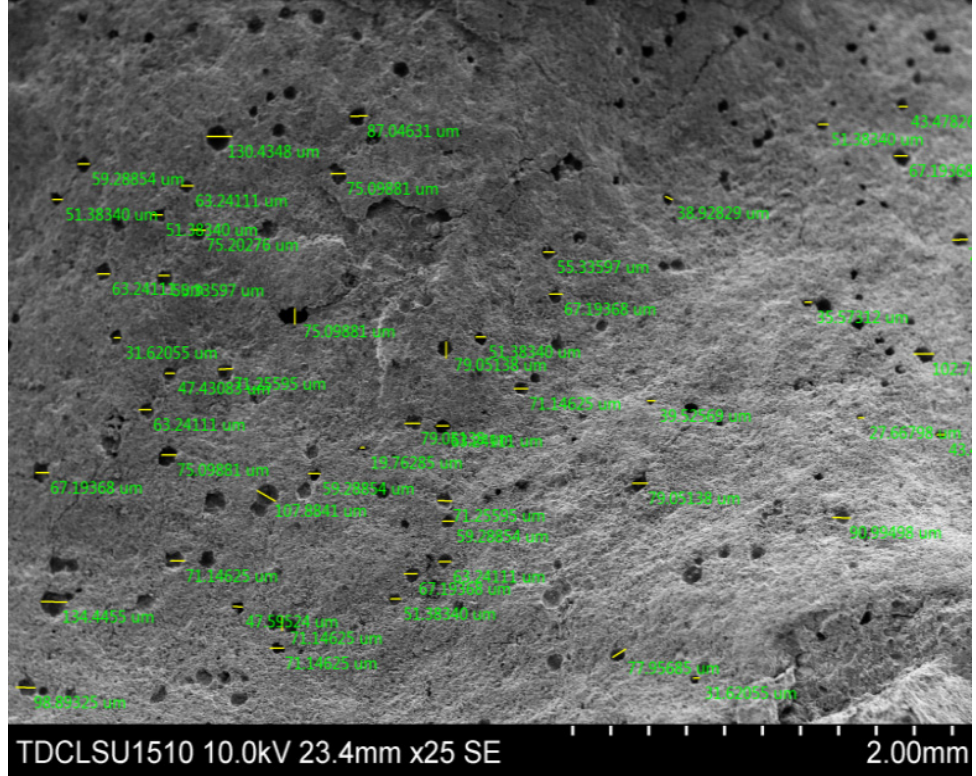
Figure 9. SAP bubble group in concrete.